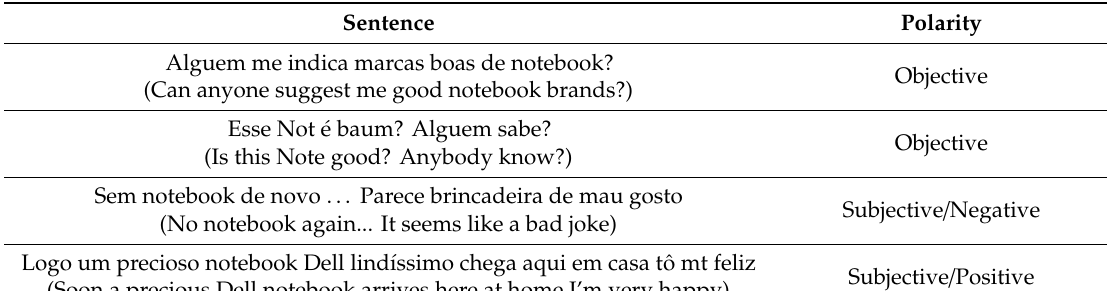
Table 1. Examples of labeled sentences in the computer-BR corpus